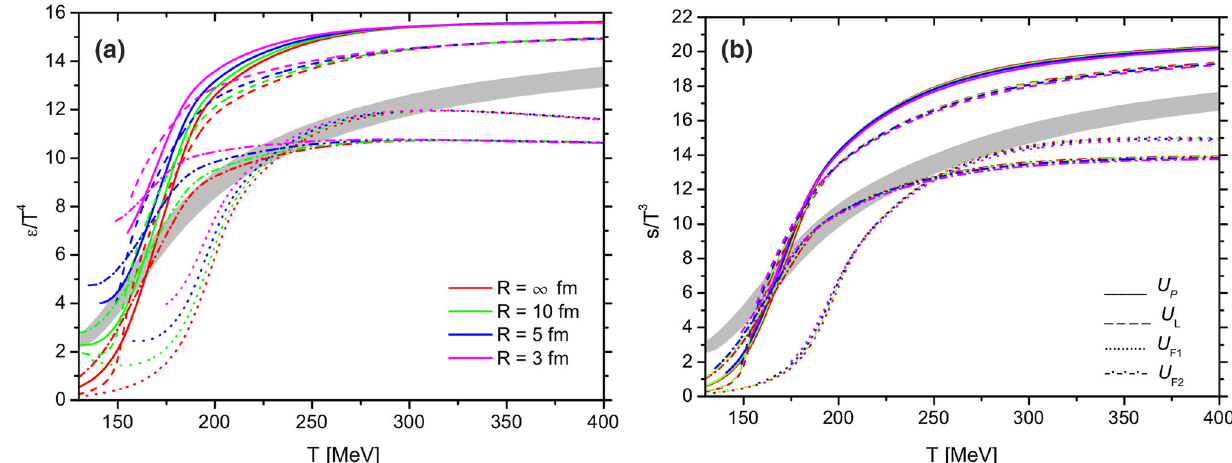
Fig. 5 Energy density and entropy density as functions of temperature. Lattice data (gray band) are taken from